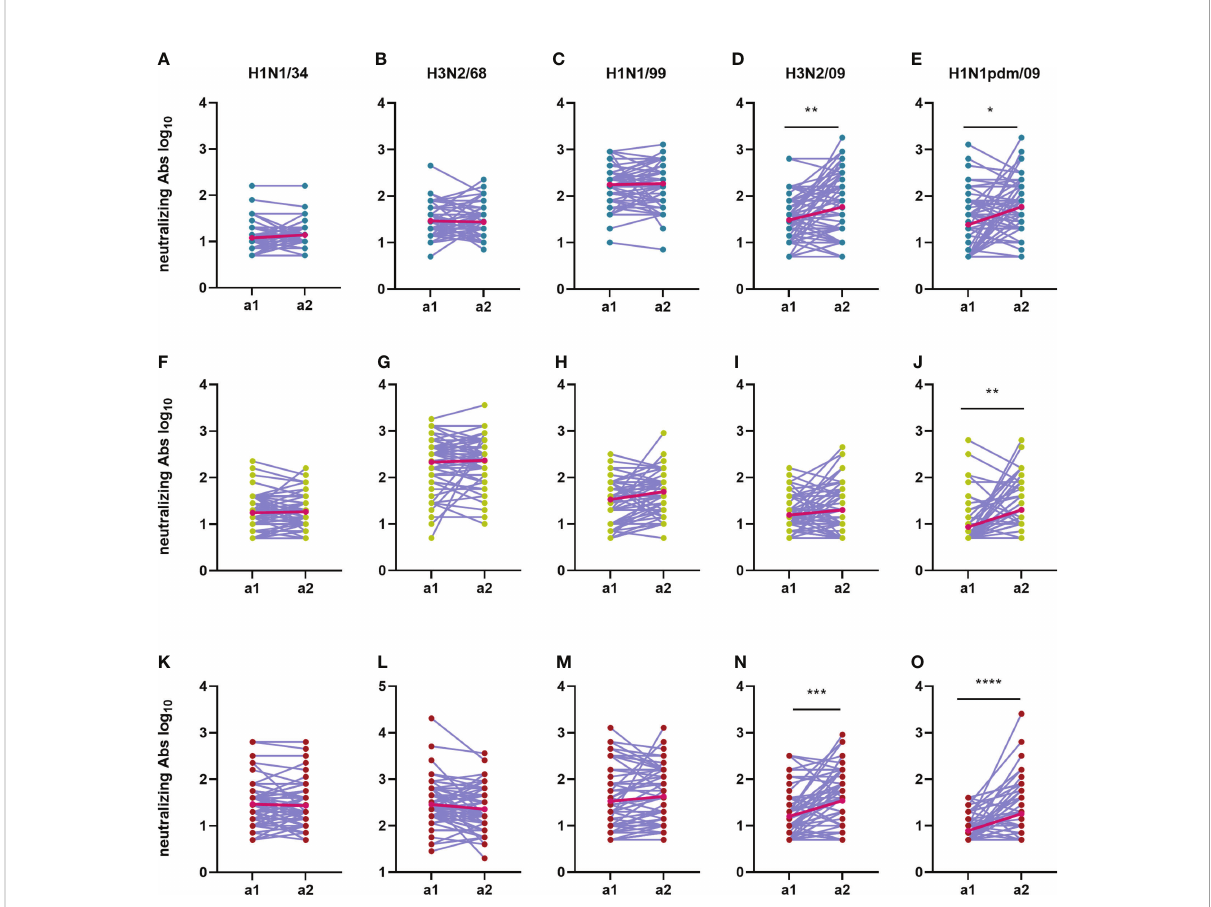
FIGURE 7 Change in neutralizing antibody titers over time during an interval of 5 years. The neutralizing antibody titers from 180 subjects during the fi rst sampling moment (a1) are compared with the neutralizing titers from the second sampling moment (a2) for each virus strain ( A, F, K : H1N1/34; B, G, L : H3N2/68; C, H, M : H1N1/99; D, I, N : H3N2/09; E, J, O : H1N1pdm/09) and age group ( A – E : adolescents; F – J : adults; K – O : elderly). Titers of a given individual in a1 and a2 are connected by a line. Geometric means for the two assessments are depicted in the graphs as bright red dots which are connected by a red line for easy visualization of the mean increase. Data were compared using Wilcoxon matched-pairs signed rank test. *P ≤ 0.05; **P ≤ 0.01; ***P ≤ 0.001; ****P ≤